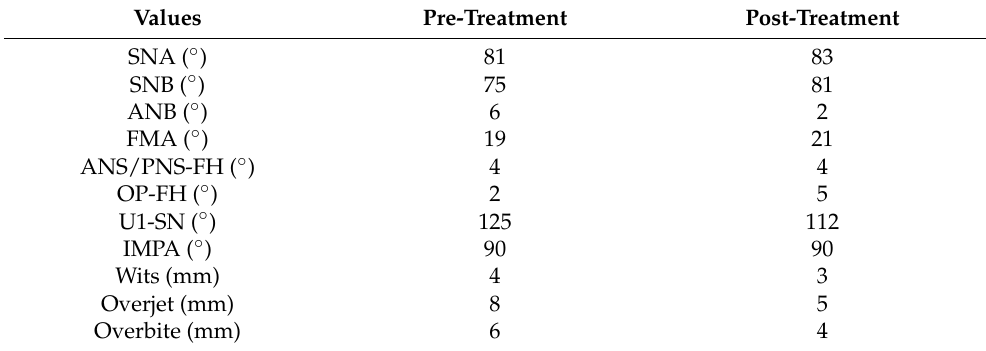
Table 1. Cephalometric values.